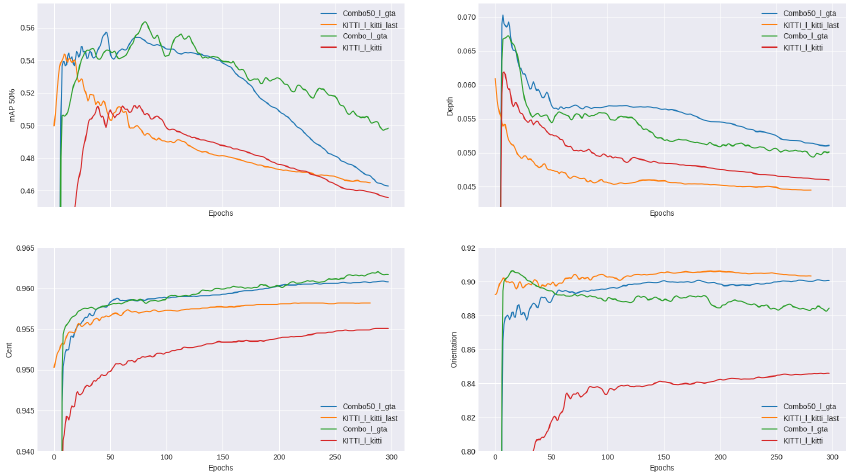
Figure 5. Inference results comparison using the previous